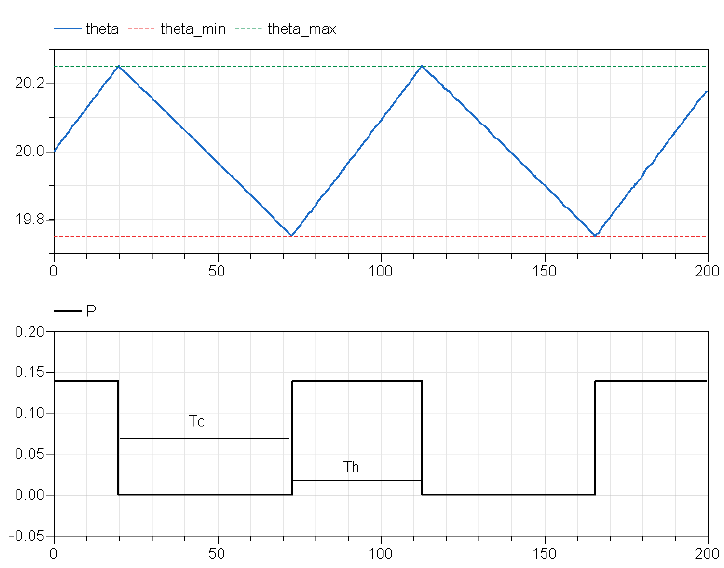
Figure 4. TCL temperature dynamics and power consumption